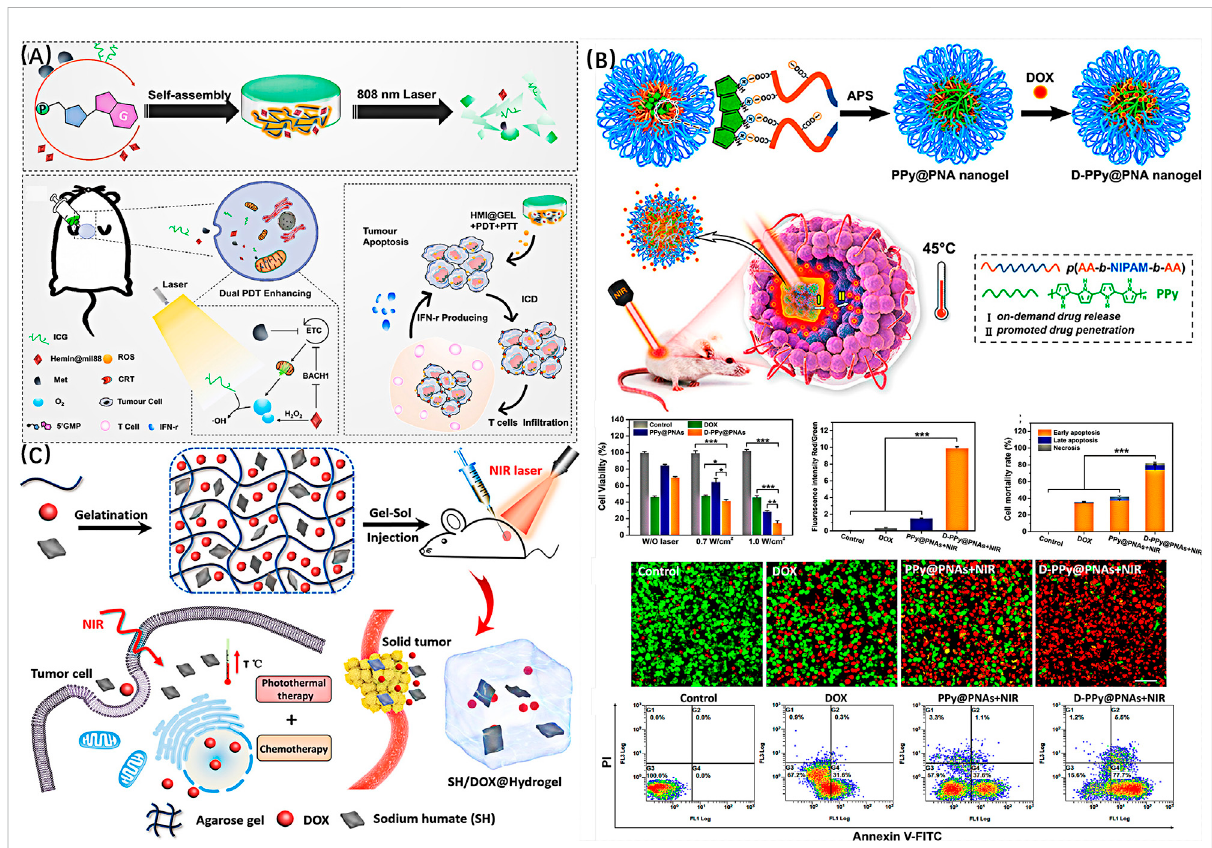
FIGURE 9 (A) Schematic illustration of HMI@GEL. Reproduced from ref. 72 with permission from 2022 Elsevier Ltd. (B) Schematic diagram of preparation oftemperaturesensitivenanohydrogelanditsapplicationintemperaturecontrolleddrugreleasefortumortreatment.Reproducedfromref.22with permission from 2020, American Chemical Society. (C) Schematic diagram of the principle of SH/DOX @ hydrogel controlling drug release and tumor ablation by using photothermal effect. Reproduced from ref. 31 with permission from 2018, American Chemical